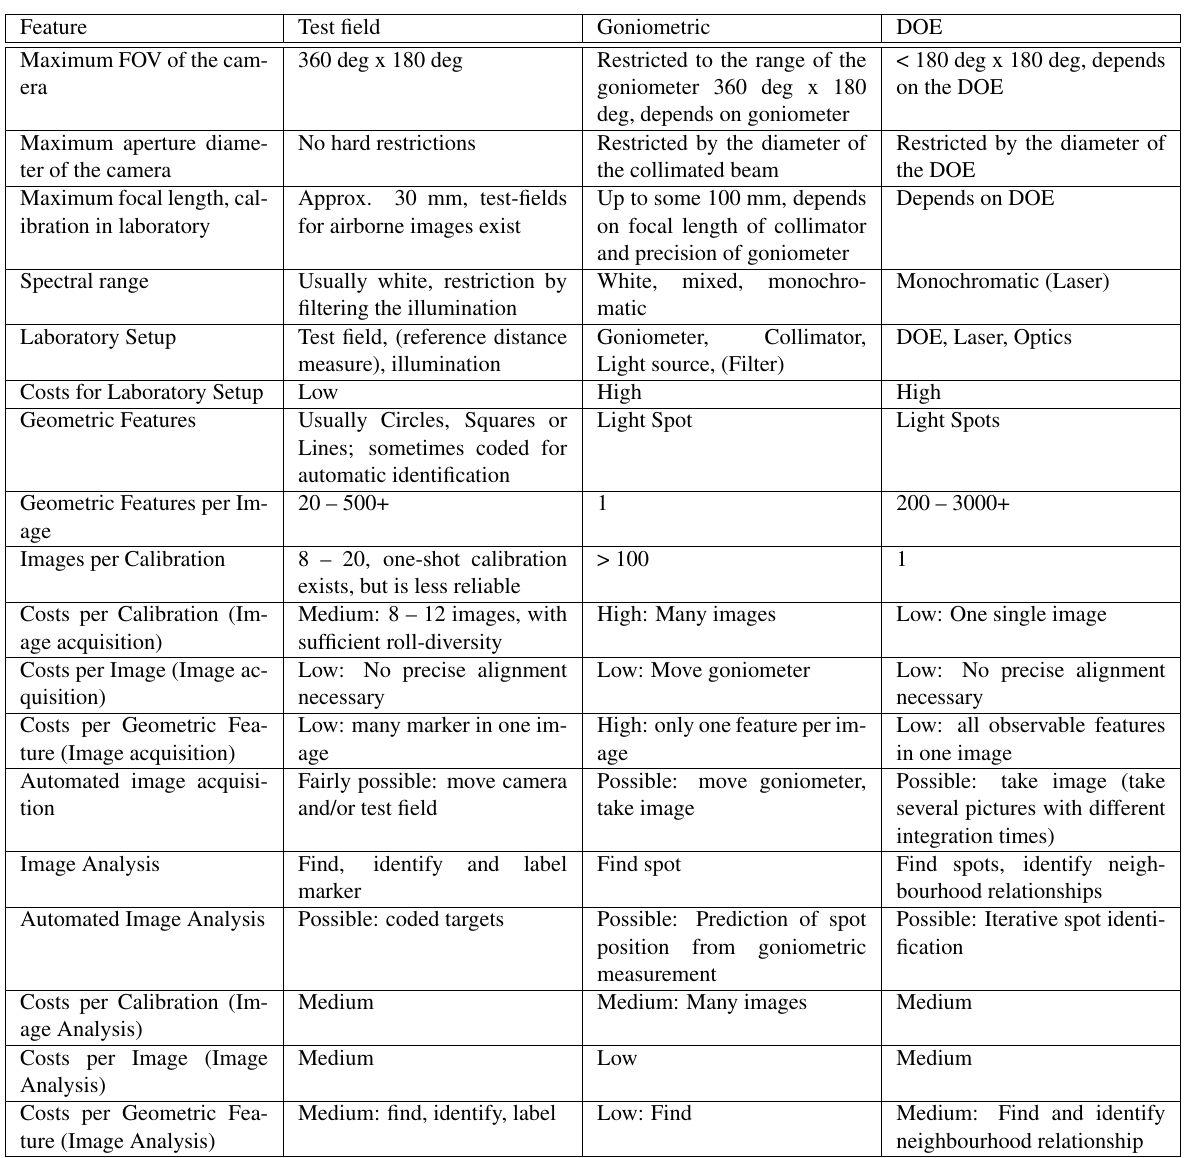
Table 1: Characteristics of calibration